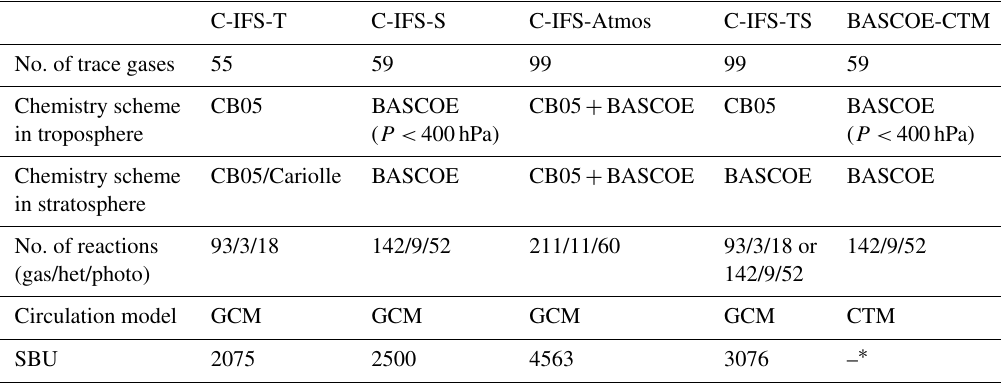
Table 2. Number of trace gases, the chemistry scheme in the troposphere and stratosphere, and the corresponding number of reactions (gas-phase, heterogeneous and photolytic), as well as specification of the circulation model and computational expenses of a 1-month run on T255L60 in terms of system billing units (SBU) for various C-IFS model versions. For completeness the BASCOE-CTM system is also